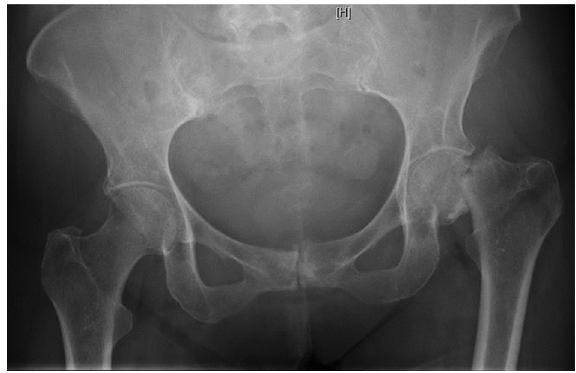
Figure 1. Left hip femoral neck stress fracture.